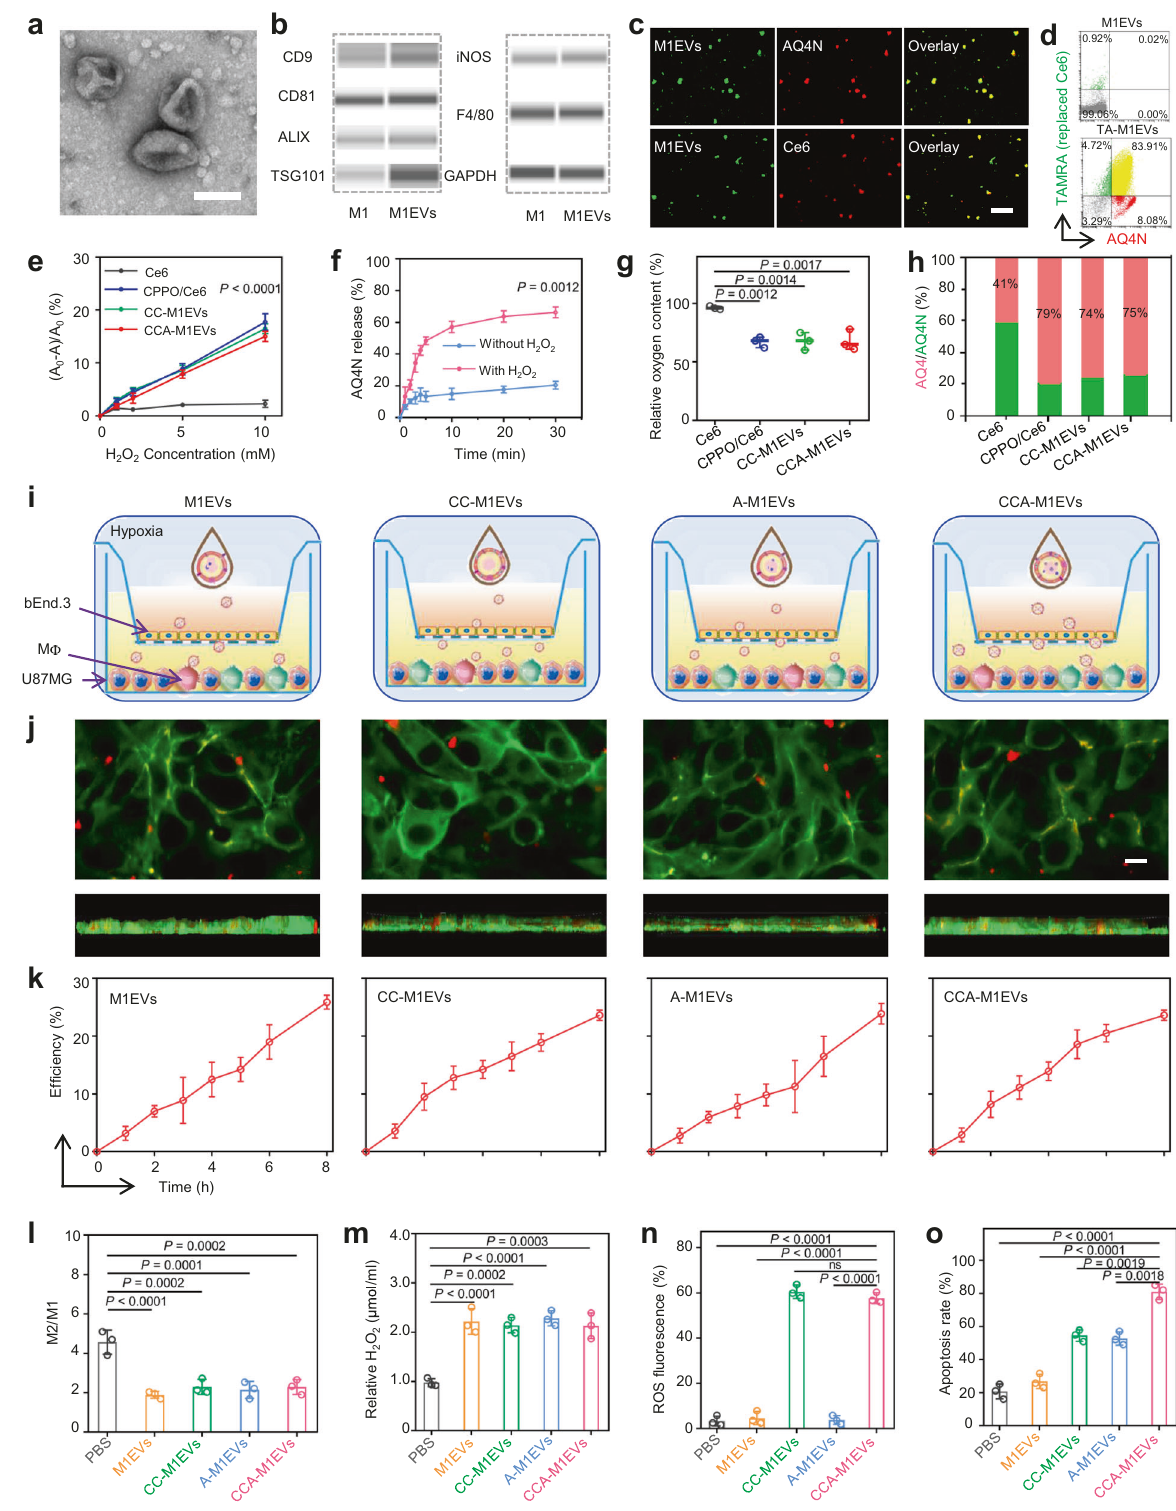
above data, combined with the absorbance spectra of AQ4N and Ce6 (Supplementary Fig. S6), con fi rmed the successful encapsula- tion of AQ4N and Ce6 into CCA-M1EVs. Subsequently, the mosaic of CPPO with CCA-M1EVs was veri fi ed by high-performance liquid chromatography (HPLC). The loading capacities of CPPO, Ce6, and AQ4N were calculated to be 7.3, 7.5, and 18.5 µg per 100 µg Signal Transduction and Targeted Therapy (2022)